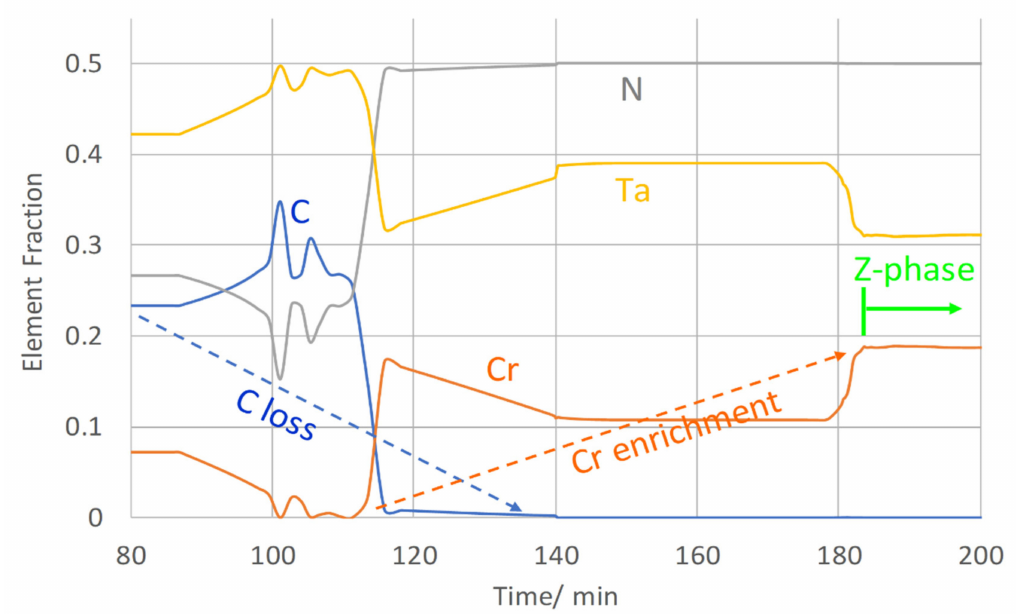
Figure 15. Outtakes of MX chemistry evolution during normalizing and tempering